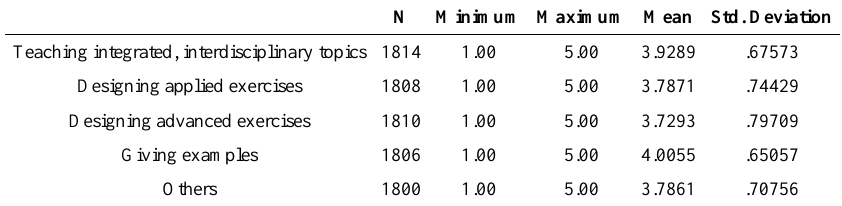
Table 5. Methods of using idioms and proverbs in mathematics teaching